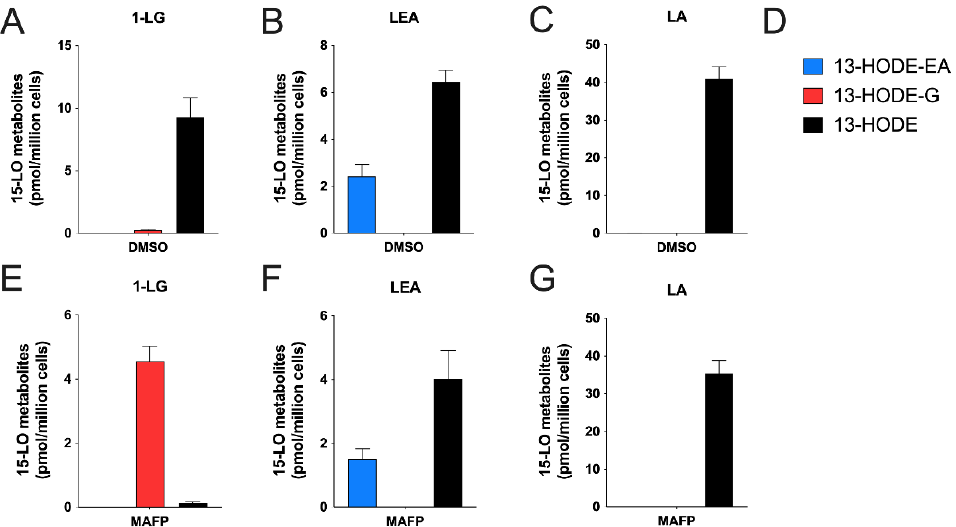
Figure 6. 15-LO metabolite production in response to LA, 1-LG, or LEA by human neutrophils. Pre-warmed human neutrophil suspensions (37 ◦ C, 5 × 10 6 cells/mL in HBSS containing 1.6 mM CaCl 2 ) were pre-treated with DMSO ( A – C ) or MAFP ( E – G ) for 5 min before the addition of 3 µM of either ( A , E ) 1-LG, ( B , F ) LEA, ( C , G ) LA. ( D ) Metabolite legend for panels A – G . Incubations were stopped after 5 min by the addition of one volume of cold ( − 20 ◦ C) MeOH containing the internal standards. Samples then were processed for LC-MS/MS analyses as described in methods. Results are the mean (±SEM) of 4 independent experiments.